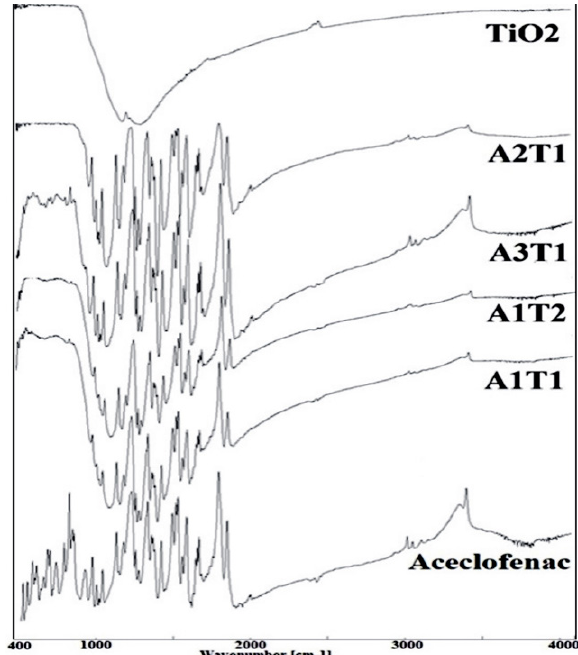
Figure 1. FTIR spectra of pure aceclofenac, TiO 2 and solid formu-